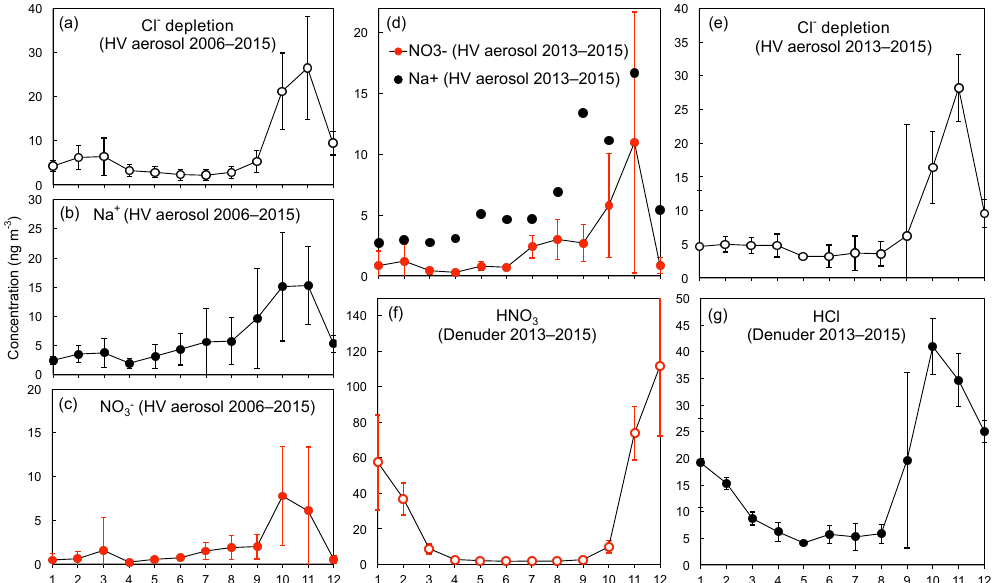
Figure 4. (a–c) Monthly mean Cl − depletion relative to Na + with respect to the composition of freshly emitted sea-salt aerosol (a) , concen- (c) in bulk aerosol. (d–g) Monthly mean Na + and NO − trations of Na + (b) and NO − concentrations (d) and Cl − depletion relative to Na + 3 3 with respect to the composition of freshly emitted sea-salt aerosol (e) in bulk aerosol (2013–2015) together with concentrations of HCl (g) and HNO 3 (f) sampled on denuder tubes over the same time period. Vertical bars refer to the year-to-year variability.